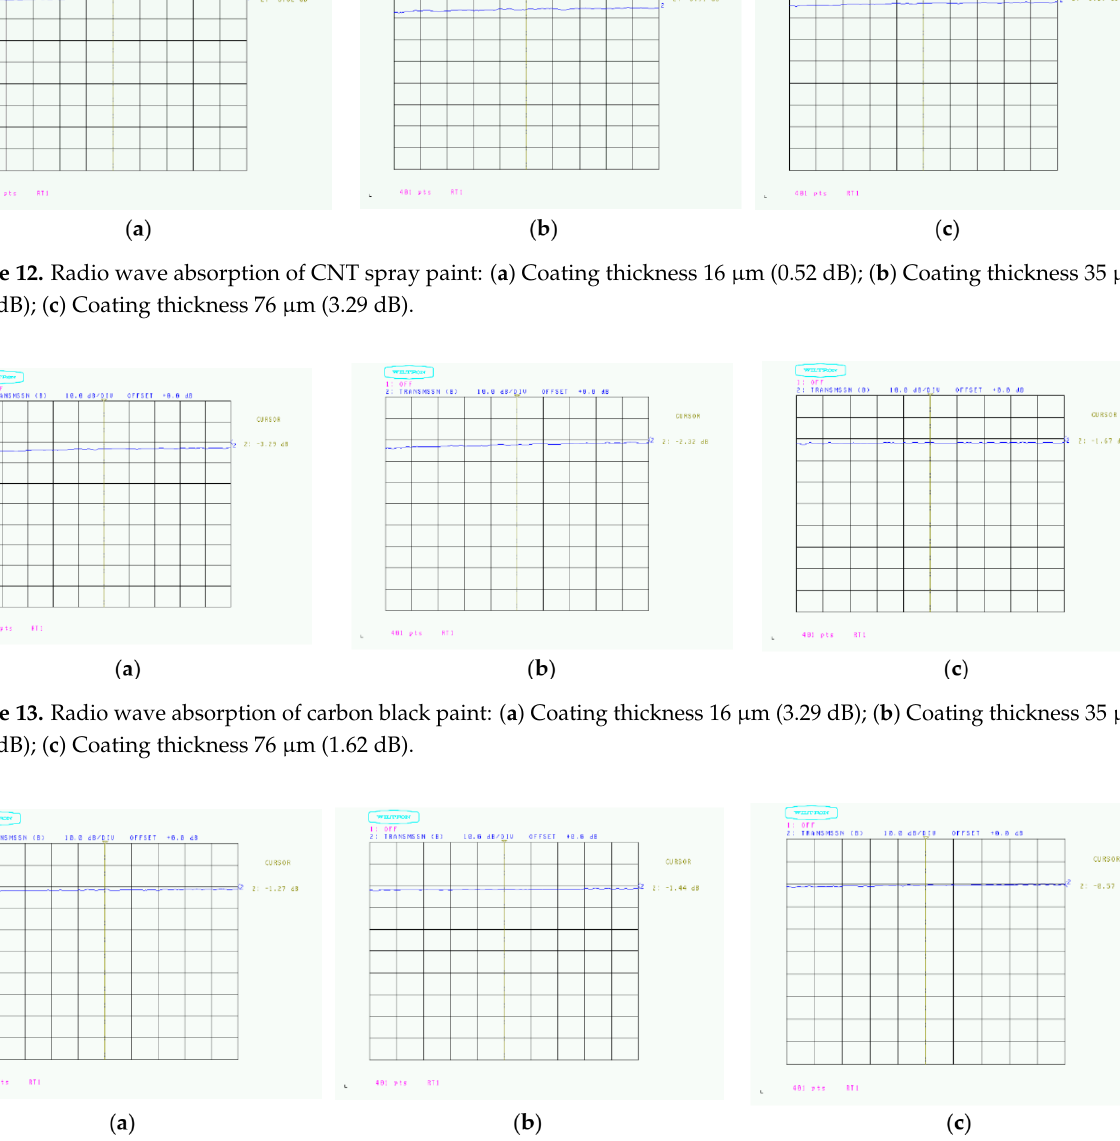
Figure 14. Radio wave absorption of graphite paints: ( a ) Coating thickness 15 µ m (1.27 dB); ( b ) Coating thickness 36 µ m (1.44 dB); ( c ) Coating thickness 74 µ m (0.57